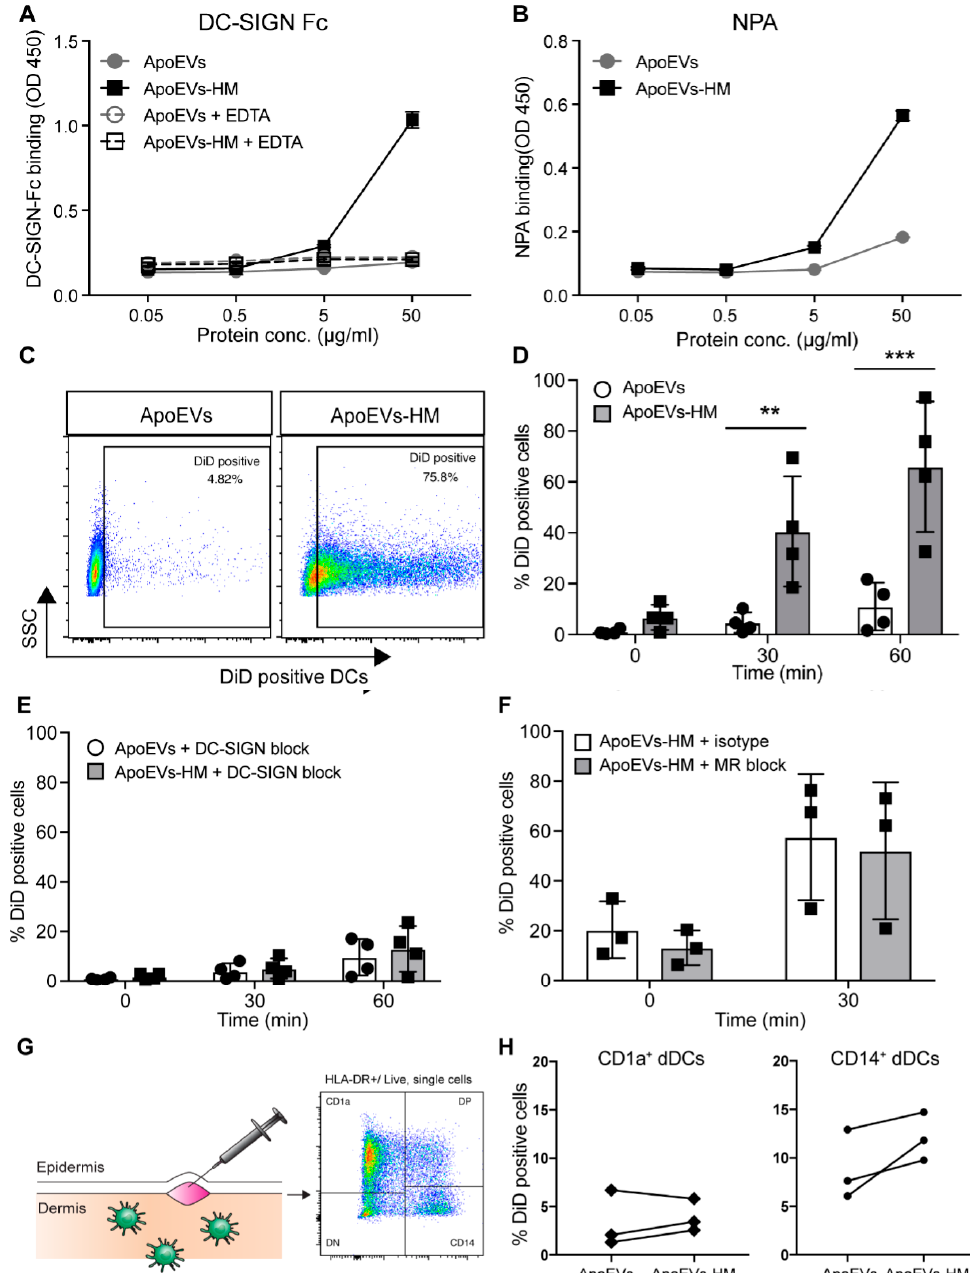
Figure 2. The expression of high-mannose glycans on ApoEVs mediates DC-SIGN binding. ( A , B ) Mel-JuSo-derived ApoEVs and ApoEVs-HM were coated, and DC-SIGN binding ( A ) and NPA binding ( B ) were detected by DC-SIGN-Fc or the lectin Narcissus pseudonarcissus agglutinin (NPA), respectively. Data shown as mean ± SD; representative of three individual experiments. ( C – F ) MoDCs were pulsed with DiD-labeled ApoEVs and ApoEVs-HM for 45 min at 4 °C, before cells were transferred to 37 °C. Uptake was measured by flow cytometry. ( C ) Representative flow cytometry data at time point 60 min. ( D ) Uptake of ApoEVs and ApoEVs-HM by moDCs after 0, 30, and 60 min. Data shown as mean ± SD of four donors. Statistics performed; two-way repeated measures ANOVA with Sidak post-hoc test. ** p < 0.01, *** p < 0.001. ( E ) MoDCs were blocked with a DC-SIGN blocking Ab (AZN-D1) or ( F ) MR blocking Ab 30 min prior to the loading with the ApoEVs or ApoEVs-HM. Data shown as mean ± SD of four donors ( E ) or three ( F ) donors. Statistics performed; two-way repeated measures ANOVA with Sidak post-hoc test. ( G ) Gating strategy for the CD1a + and CD14 + dermal DCs (dDCs). ( H ) Uptake of DiD-labeled ApoEVs and ApoEVs-HM by migrated dDCs following in situ injection.